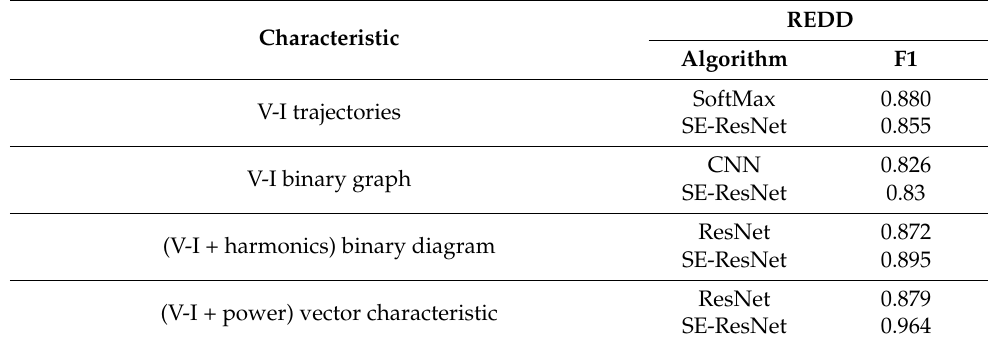
Table 5. Comparison of results of different methods based on REDD data sets. Characteristic